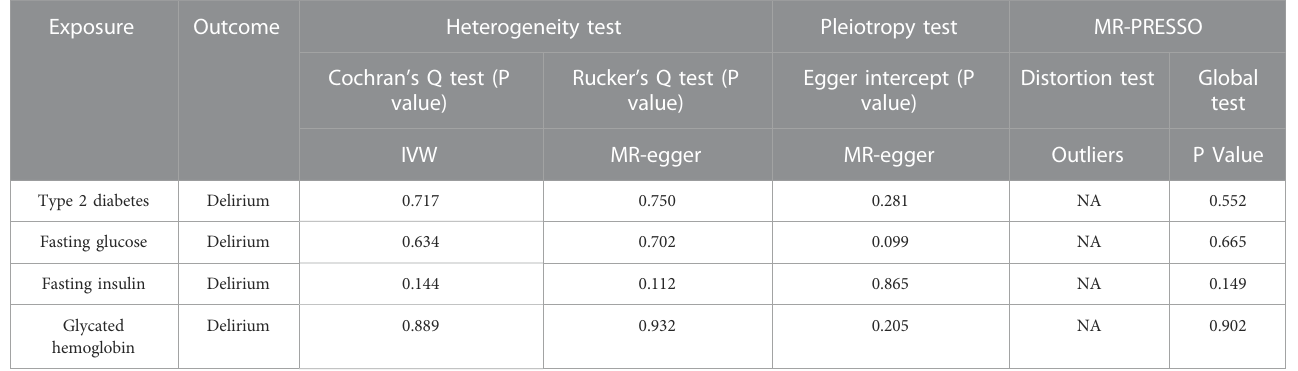
TABLE 1 Sensitivity analysis of the MR analysis results of exposures and